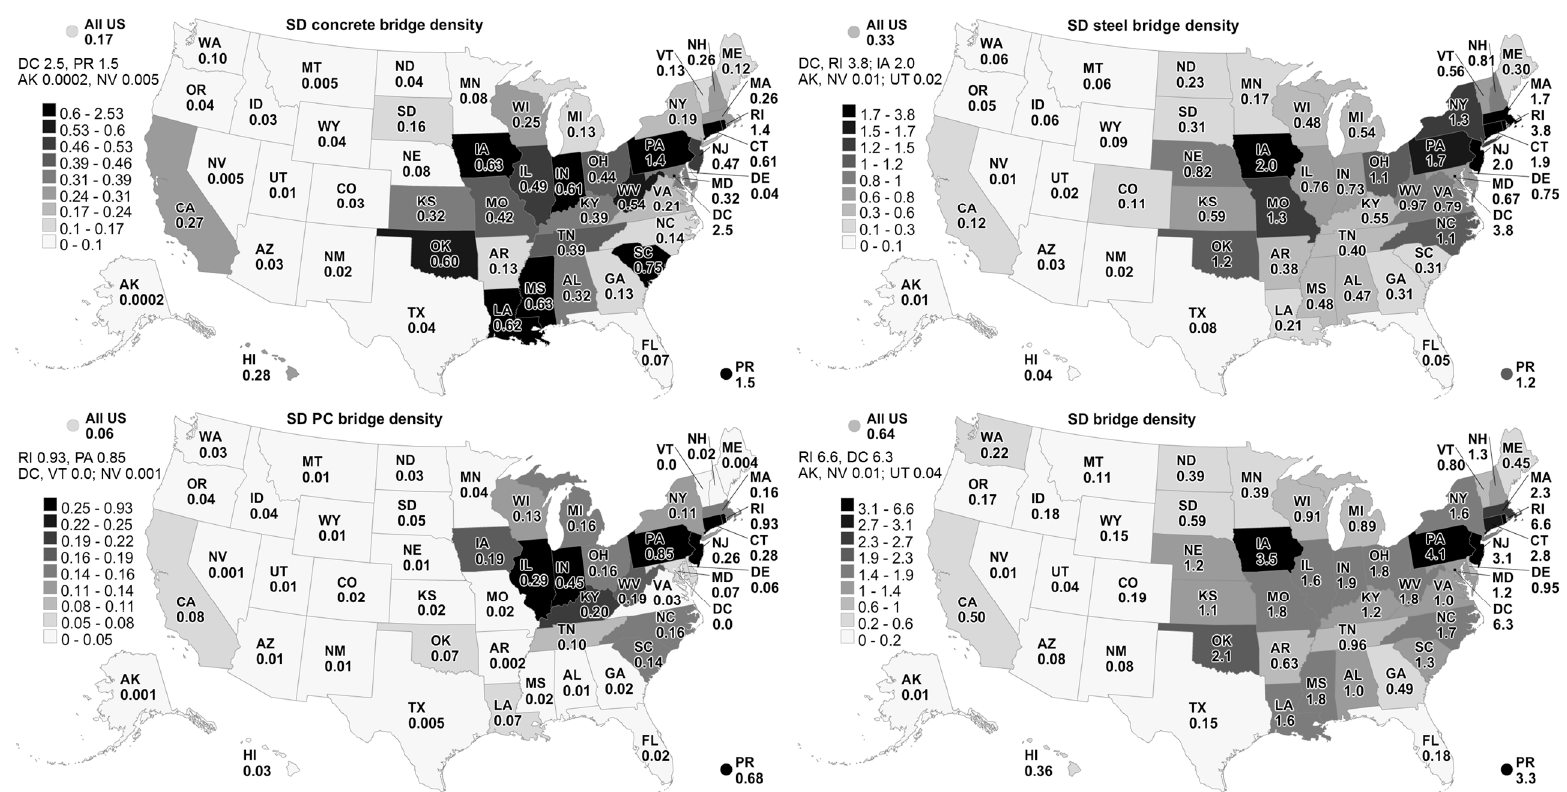
Figure 4. Density (count/10 8 m 2 ) of structurally deficient bridges by state.